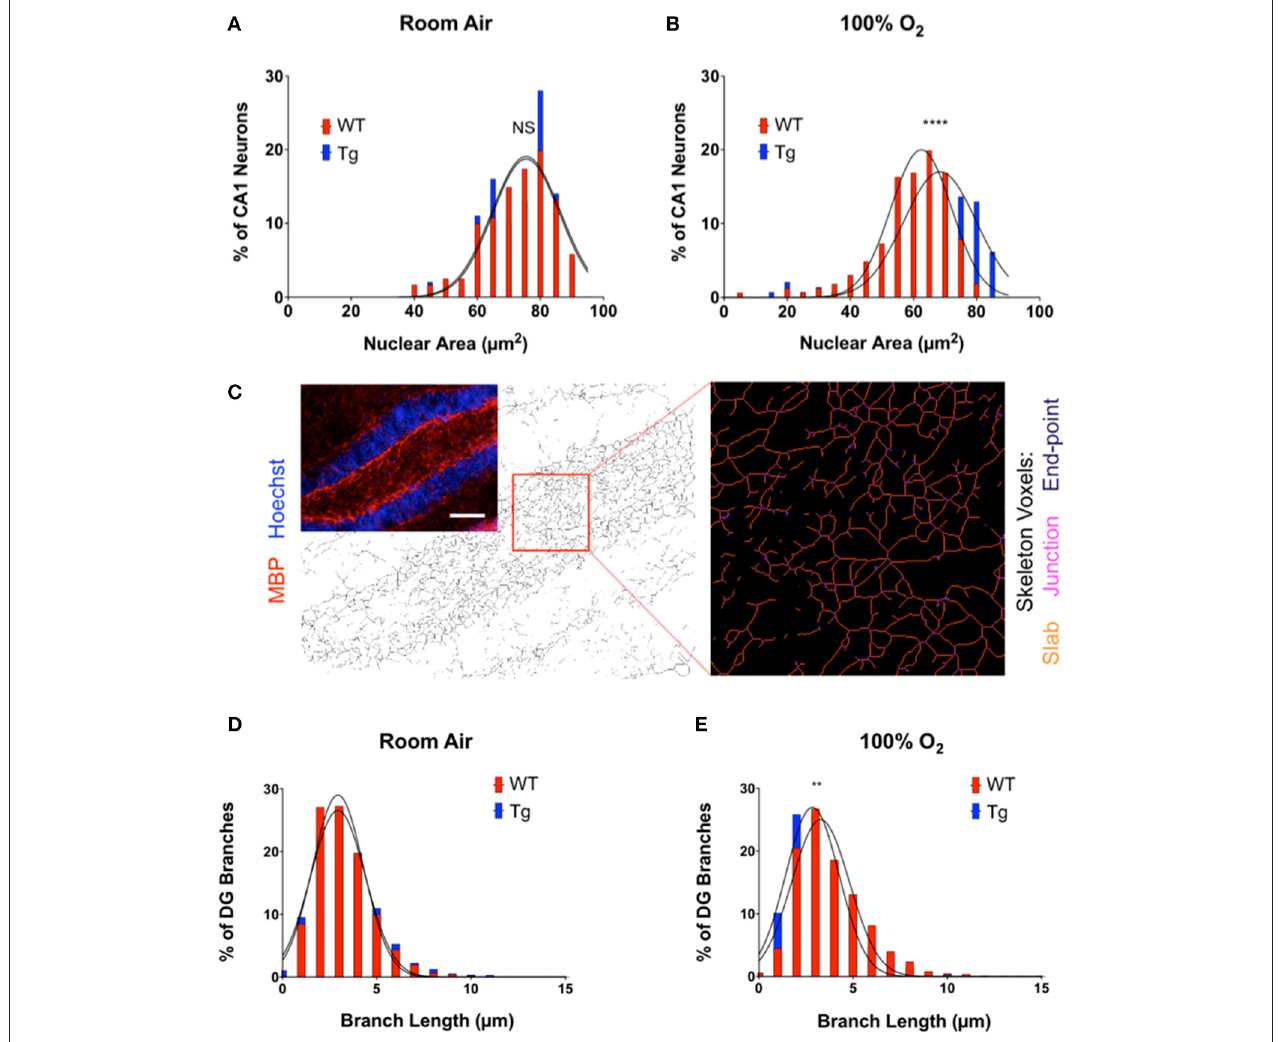
FIGURE 5 | Over-expression of EC-SOD in the lung protects against hyperoxia-induced changes in neuronal morphology in CA1 and DG of the hippocampus. (A) Over-expression of EC-SOD has no effect on CA1 nuclear size in the CA1 field. Distribution and Gaussian curve fit of neuronal nuclear size in the CA1 field performed in room air-treated mice (WT, 72.80 µ m 2 ± 11.04 vs. EC-SOD, 73.83 µ m 2 ± 9.97; p = 0.74 for comparison of Gaussian curves). (B) Over-expression of EC-SOD in the lung blocks hyperoxia-induced nuclear shrinkage in exposed CA1 neurons (WT, 59.38 µ m 2 ± 12.09 vs. EC-SOD, 65.23 µ m 2 ± 14.06; **** p < 0.0001 for comparison of Gaussian curves). (C) Transgene expression of EC-SOD in the lung inhibits hyperoxia-induced fiber sprouting in the hilus of the dentate gyrus (DG). Skeleton analysis of MBP + neurites in the DG hilus. Scale bar = 400 µ m. (D) Histogram and Gaussian curve fit of branch lengths in the DG with no differences in room air-treated mice (WT, 3.23 µ m ± 1.48 vs. EC-SOD, 3.36 µ m ± 1.74; p = 0.27 for comparison of Gaussian curves). (E) Neonatal hyperoxia induces neurite sprouting in adult WT when compared to adult Sftpc EC − SOD mice (WT, 3.79 µ m ± 1.84 vs. EC-SOD, 3.33 µ m ± 1.75; ** p < 0.01 for comparison of Gaussian curves). ( n = 4–5 mice per